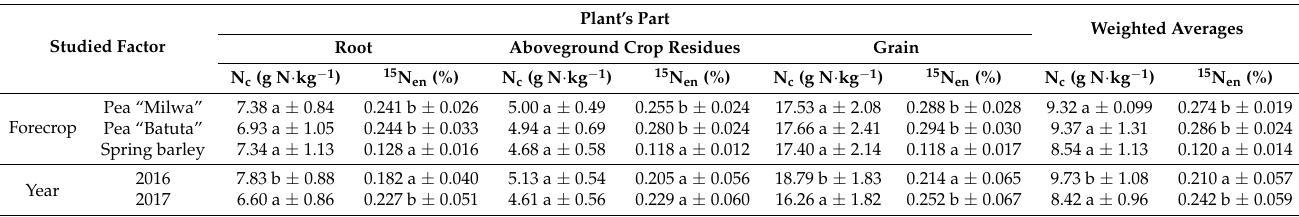
Table 5. Nitrogen content (Nc) (g N · kg − 1 ) and enrichment with 15 N ( 15 Nen) (%) in winter triticale’s dry weight (averages ± SD).